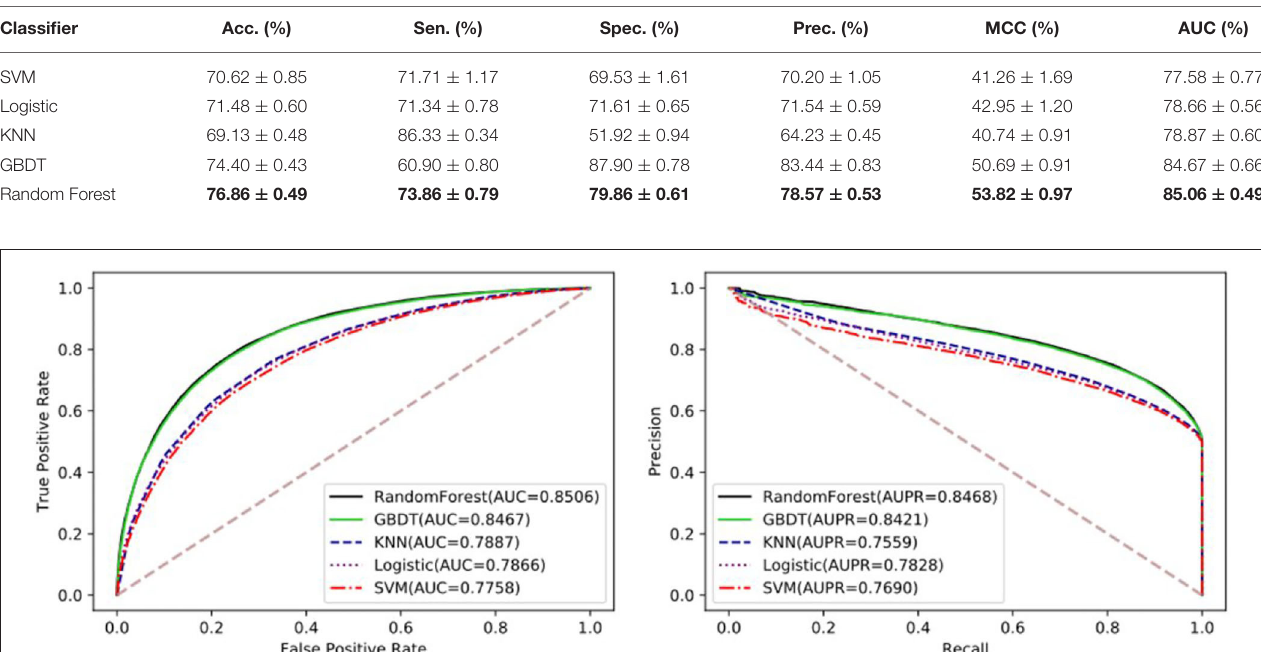
TABLE 3 | Comparison of different machine learning classifier under five-fold cross-validation.